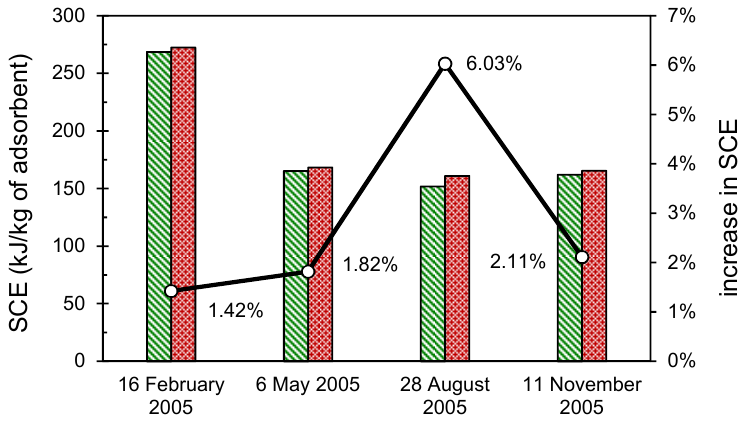
Figure 13. Performance with the east and west wings of 1.25 m length and percentage increase compared with a linear CPC (28 August 2005). SCE: specific cooling effect.